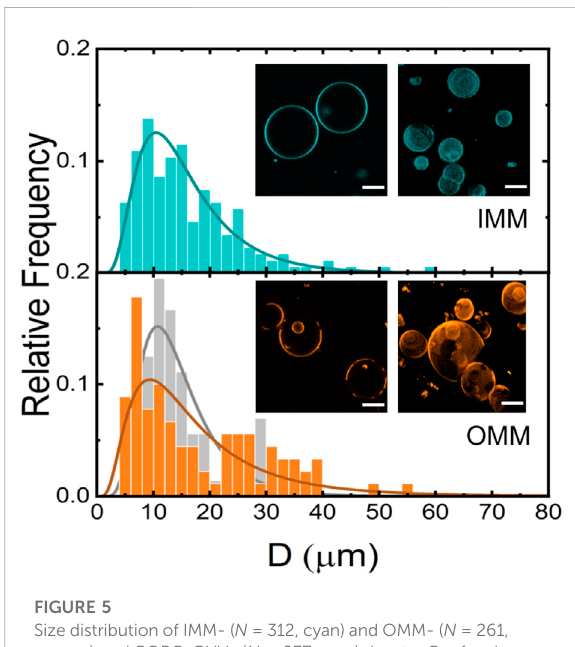
FIGURE 5 Size distribution of IMM- ( N = 312, cyan) and OMM- ( N = 261, orange) and POPC-GUVs ( N = 237, gray). Insets: Confocal fl uorescence microscopy images of IMM and OMM-GUVs. Unstained areas correspond to l o domains. Scale bars are 10 μ